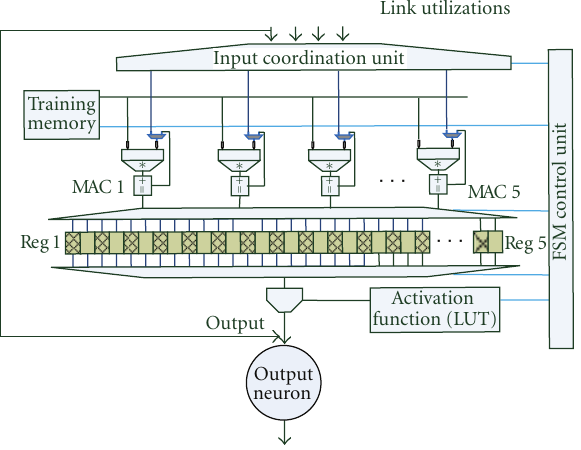
Figure 6: ANN hardware architecture and its hardware